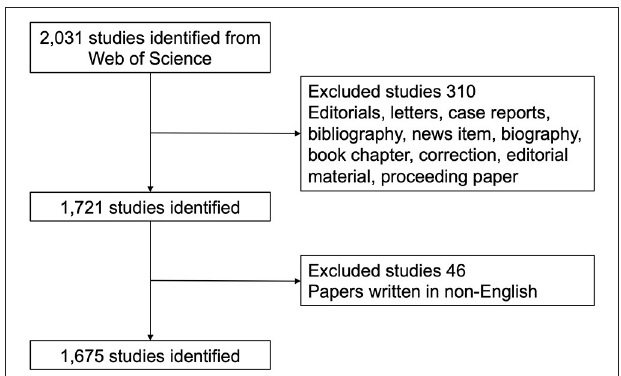
FIGURE 1 | Flow diagram of the inclusion process. The detailed process of searching and